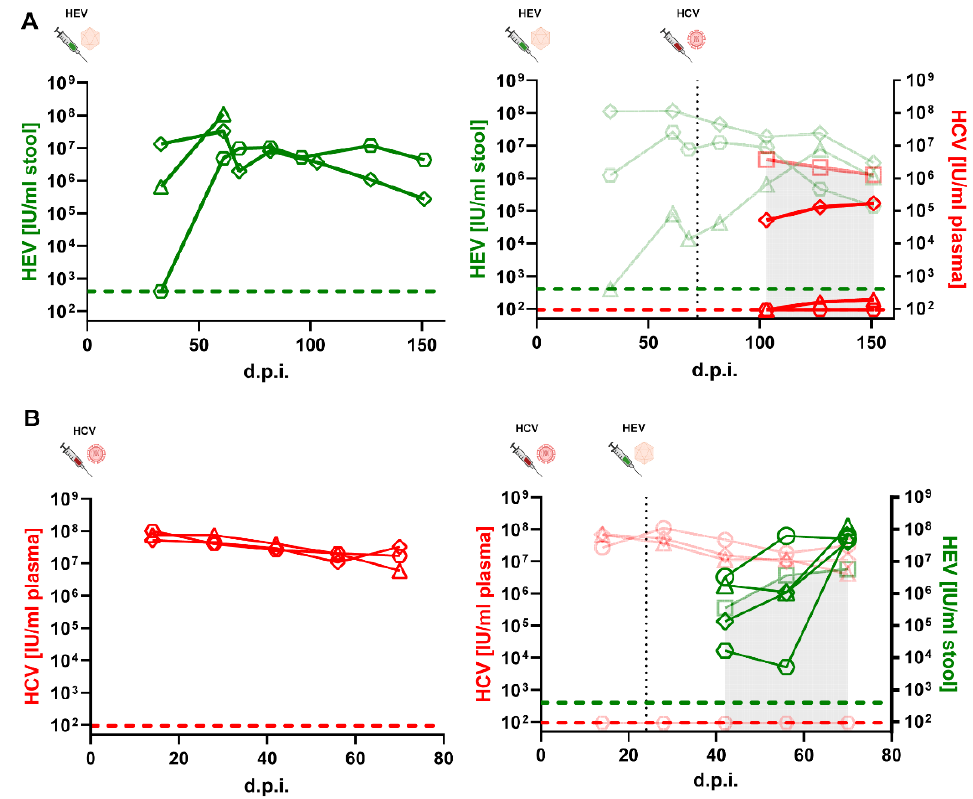
Figure 6. HCV or HEV super-infections on HEV- or HCV-infected humanized mice. ( A ) Human liver chimeric uPA +/+ -SCID mice were injected intraperitoneally with HEV and subsequently in- jected intravenously with HCV (black dashed line). HEV RNA (green data points) and HCV RNA (red data points) were periodically measured. Left panel: HEV viral loads of HEV mono-infected mice. Right panel: HEV viral loads of HEV co-infected animals as well as mean HCV titers of HCV mono-infected (semitransparent data points) and HCV titers of HCV co-infected mice. Green dashed line and red dashed line indicate the limit of detection (LOD) of the HEV or HCV RT qPCR, respectively. ( B ) Human liver chimeric uPA +/+ -SCID mice were injected intravenously with HCV and subsequently injected intraperitoneally with HEV (black dashed line). HEV RNA (green data points) and HCV RNA (red data points) were periodically measured. Left panel: HCV viral loads of HCV mono-infected mice. Right panel: HCV titers of HCV co-infected animals as well as mean HEV viral loads of HEV mono-infected (semitransparent data points) and HEV viral loads of HEV co infected mice. Green dashed line and red dashed line indicate the LOD of the HEV or HCV RT qPCR, respectively.